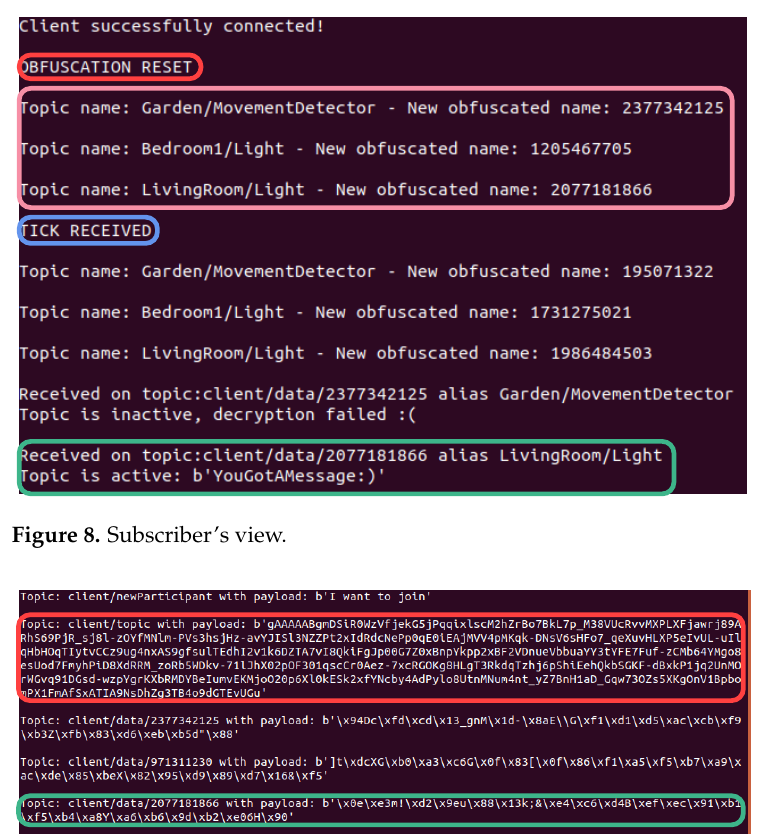
Figure 9. Broker’s View